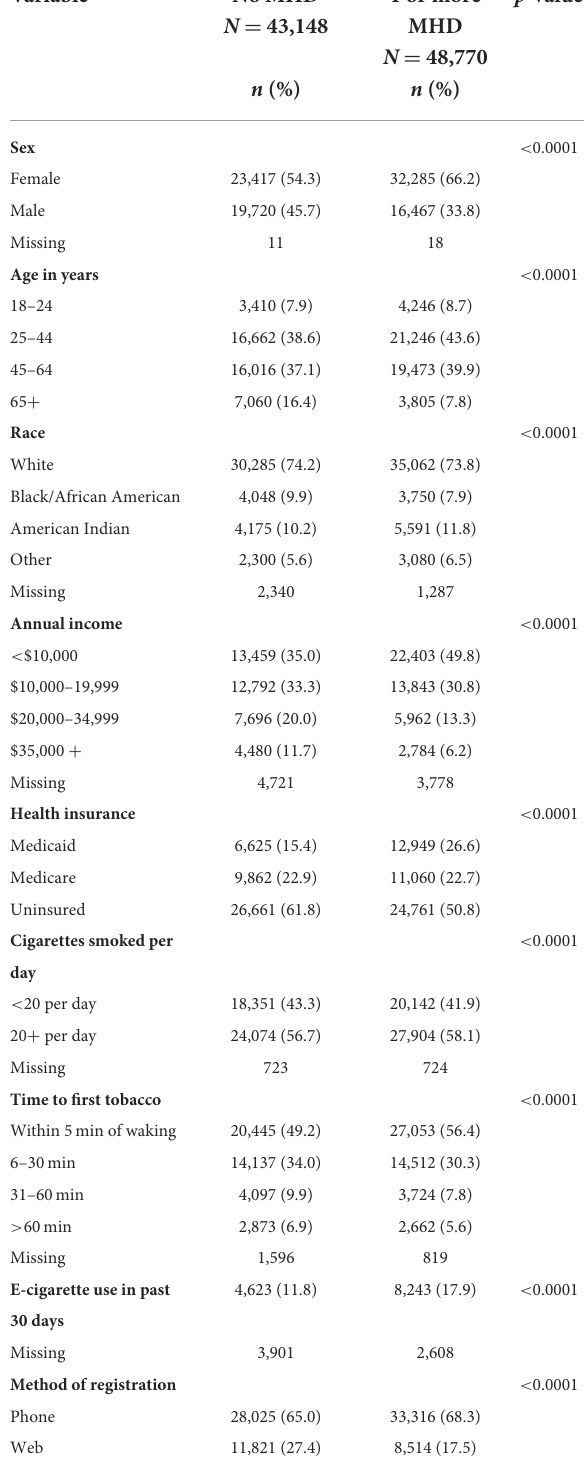
TABLE 1 Characteristics of tobacco users registering for Oklahoma Tobacco Helpline (OTH) services and service utilization, by mental health disorder (MHD) status, July 2015-April 2020, among those eligible for the multiple call